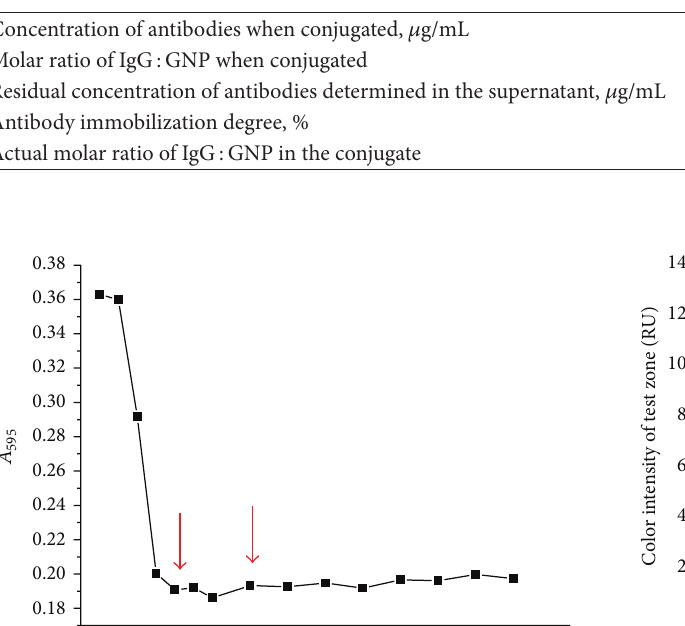
Table 1: Antibody immobilization characteristics on the GNP surface.